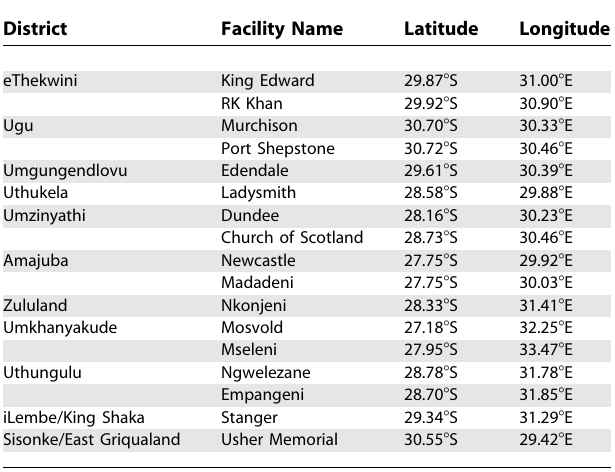
Table 1. Communities in KwaZulu–Natal with Populations of at Least 500 People